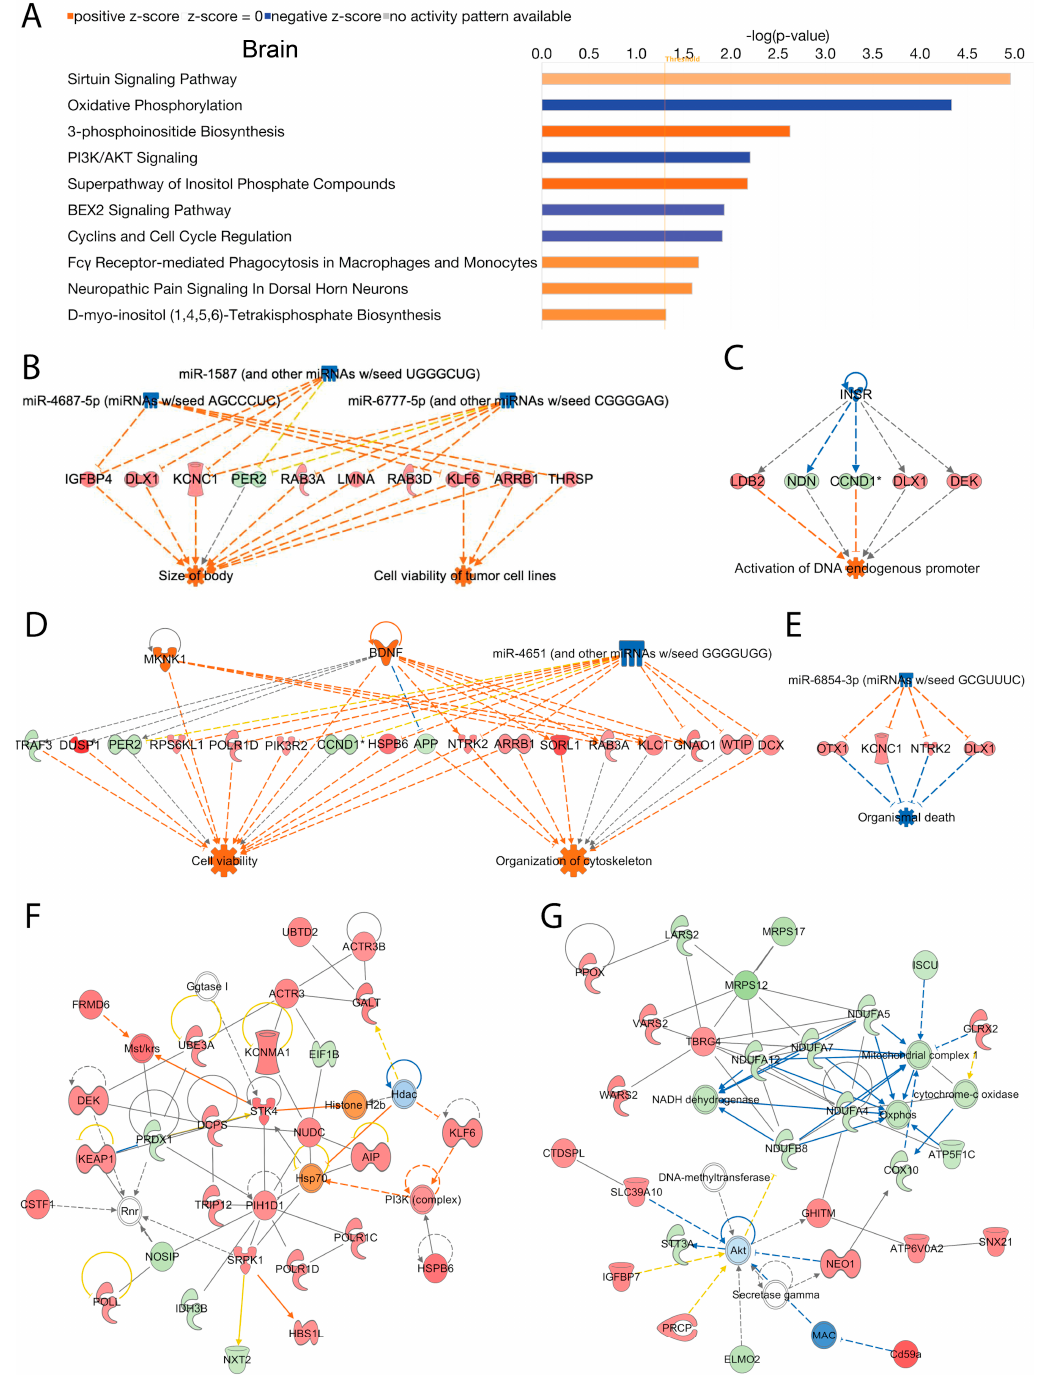
Figure 4. Brain ; Acss2 regulates several canonical signaling pathways, upstream transcriptional regulatory molecules, and cellular and molecular networks in murine brain. DEGs in Acss2 − / − mice compared to wild-type mice in brain tissue were analyzed using IPA. ( A ) The bar graph shows the top 10 activated or inhibited canonical signal transduction pathways. The bars indicate the − log ( p -value) of over-representation, while the orange line indicates the threshold. The color of the bars indicates the sign of the z-score (orange for positive z-score, blue for negative). The diagrams show the most enriched upstream transcriptional regulatory molecules including; ( B ) miR-1587, miR-4687-5p and miR-6777-5p; ( C ) INSR; ( D ) BDNF, miR-4651, MKNK1 and ( E ) miR-6854-3p, that are associated with disease and cellular function. The color scheme indicates the value of the differential expressions and the shapes indicate the type and function, as indicated in Supplementary Figure S1. Solid arrows represent the genes that interact directly, whereas the dotted arrows represent indirect interactions between genes. The most enriched networks included ( F ) Network 1: “Connective